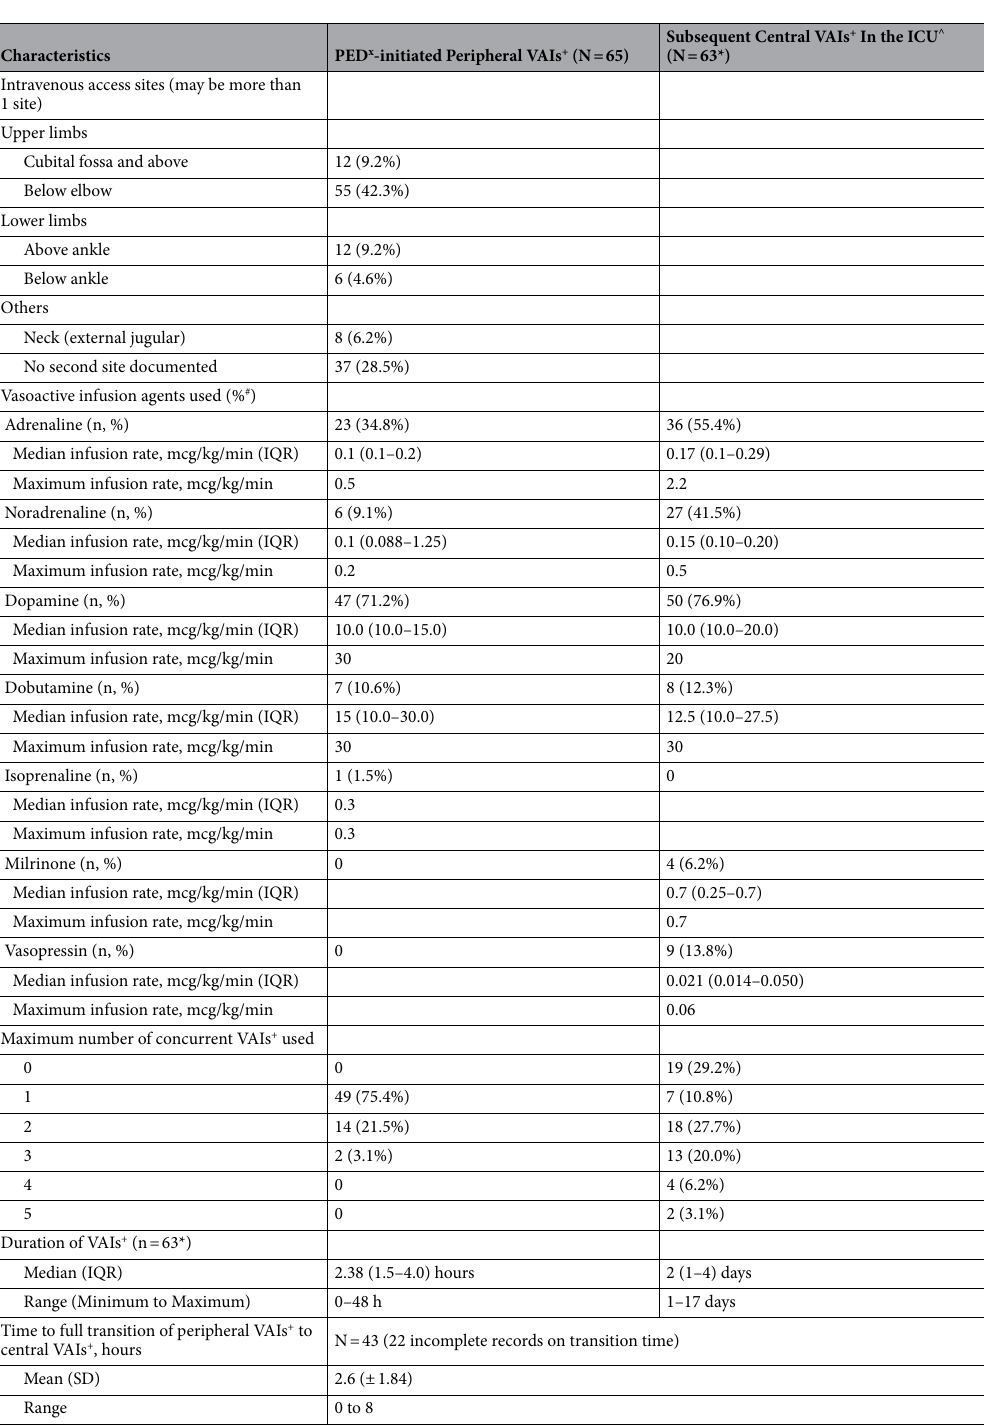
Table 2. Characteristics of peripheral access sites and peripheral vasoactive infusions used in the emergency department and subsequent intensive care management. x PED (Paediatric emergency Department), + VAIs (Vasoactive infusions), ^ ICU (Intensive care unit), # percent for that VAI of total patient population, *2 patients with incomplete intensive care